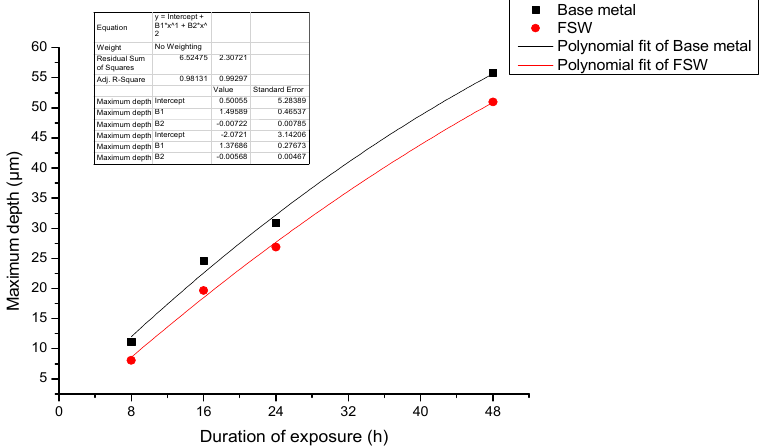
Figure 12. Fitting curve showing the variation of average depth of corrosion with duration of exposure to the aqueous environment (EXCO solution) at an applied stress ( σ ) of 0 MPa.